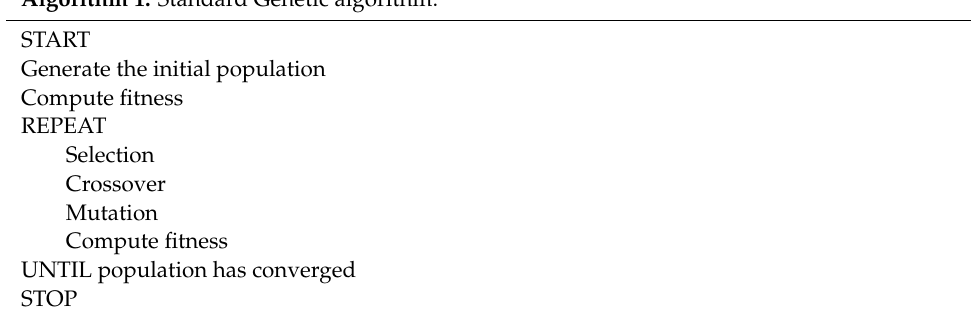
Algorithm 1. Standard Genetic